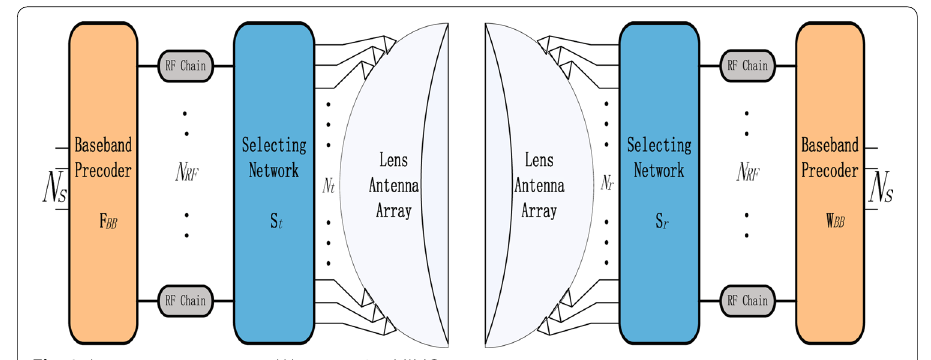
Fig. 2 Lens antenna array mmWave massive MIMO system